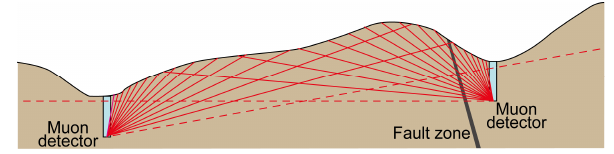
Fig. 6. 2 Fig. 6. Scheme of the down-hole muon